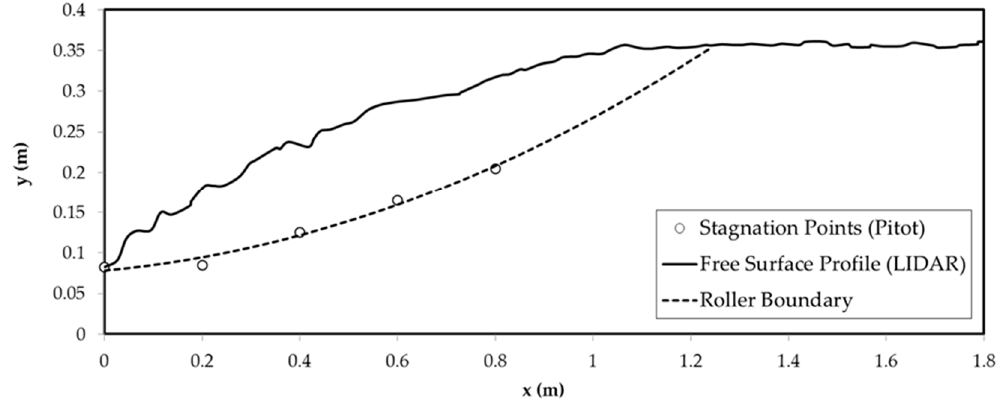
Figure 7. Stagnation point criterion to estimate the hydraulic jump roller length.